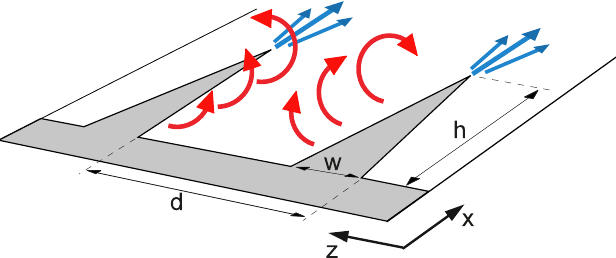
Figure 4. Sketch of the effects of triangular tips on the exposed electrode: momentum injection (blue) and vortices generation